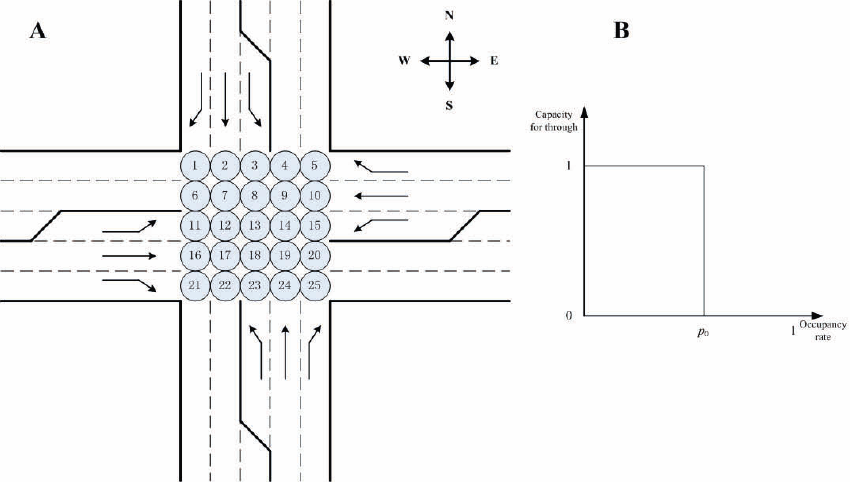
Figure 2. The gridding intersection and its characteristic. A, resolve the intersection using grids; B, the through capacity of the grid depending on its occupancy